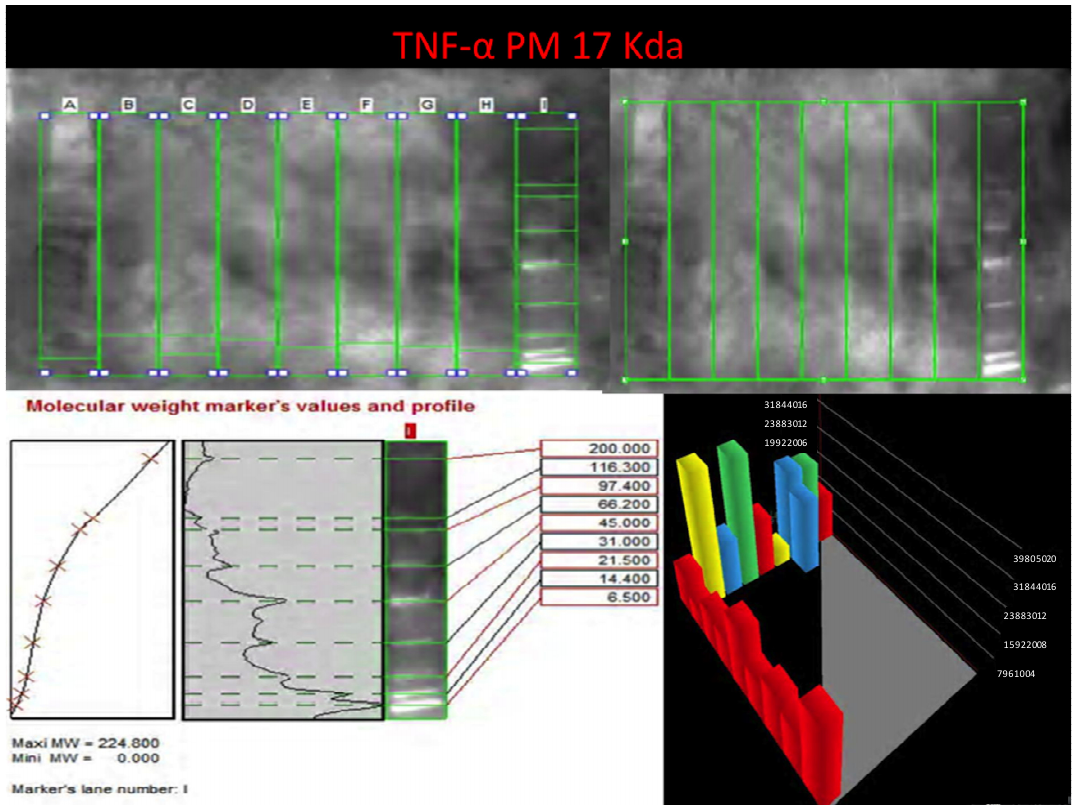
Figure 8. Western blot experiments with TNF- α antibodies using cytoplasmic and nuclear extracts from frozen brain of the different groups. On the left side representative blot for each group ( upper ) and TNF- α quantitative expression ( lower and on the right). Marker’s lines on the right side of the blot lines.